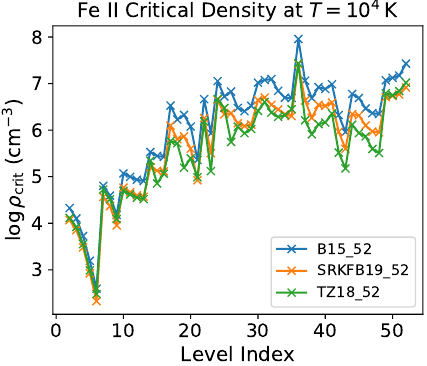
Figure 8. Critical densities for the lower 52 levels of [Fe II ] predicted at T = 10 4 K by using ECS from the coll datasets B15_52, SRKFB19_52, and TZ18_52 and A -values from atom_TZ18_52.